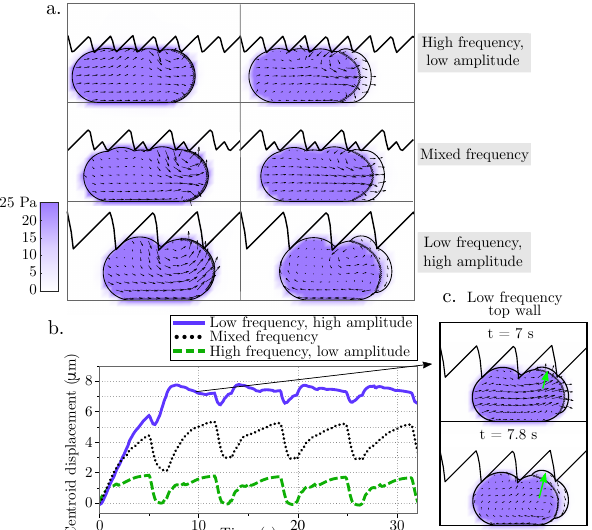
Figure 4. Displacement during blebbing in an asymmetrical rigid channel. ( a ) Cell position as the bleb expands at two time points (left panels at 19.9 s and right panels at 20.9 s) for different geometries of the top channel wall: high frequency/low amplitude, mixed frequency, and low frequency/high amplitude sawtooth. The vector field represents the intracellular fluid velocity, and the scalar color field represents cytosolic pressure. ( b ) Cell centroid horizontal displacement over time for the three different channel configurations. ( c ) The inset shows the cell configuration at two different time points as the cellular bleb expands vertically into the crevice of the top wall modeled as a sawtooth function with low frequency and high